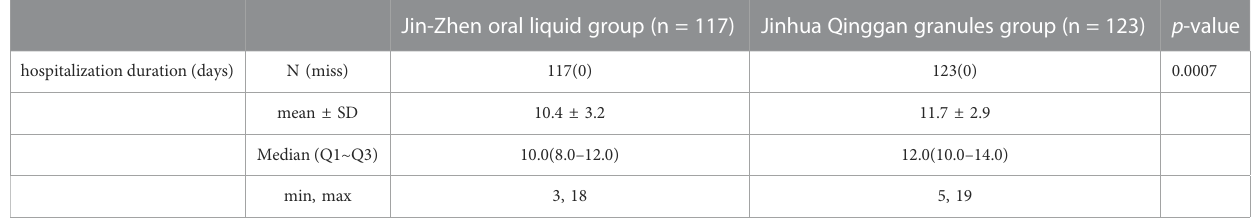
TABLE 5 Hospitalization duration in the two groups after treatment